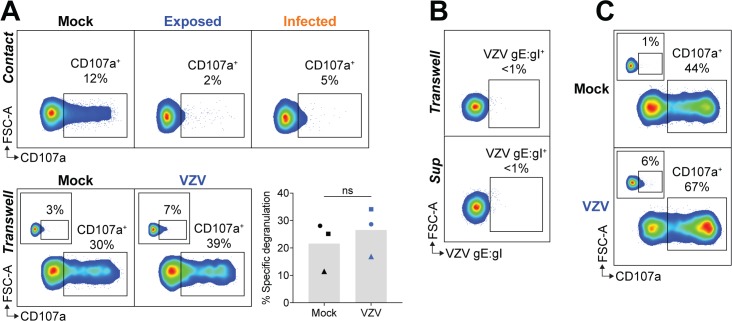
VZV inhibition of NK cell function is contact-dependent.(A) PBMCs were either mock cultured, exposed to VZV, or VZV infected (top panel), or separated from the inoculum by a Transwell membrane (bottom panel) for 1 day. PBMCs were challenged with K562 cells with IL-2 or left unstimulated (inset panels) and NK cells (viable CD3–CD56+ cells) assessed for degranulation (CD107a+) by flow cytometry. Graph shows specific degranulation against K562 cells for three donors. Symbols represent individual donors, and grey columns indicate mean. ns = not significant (two-tailed Wilcoxon test). (B) PBMCs were either separated from VZV inoculum by a Transwell membrane or treated with supernatant harvested from PBMCs cocultured with VZV inoculum. Flow cytometry plots show surface staining for VZV gE:gI on NK cells (viable CD3–CD56+ cells). (C) PBMCs were treated for 1 day with supernatant harvested from PBMCs cocultured with VZV inoculum, and challenged with K562 cells with IL-2 or left unstimulated (inset panels) and NK cells (viable CD3–CD56+ cells) assessed for degranulation (CD107a+) by flow cytometry. Data are representative of n = 3 donors (Transwell separated) (A & B) or n = 2 donors (supernatant treated) (B & C).